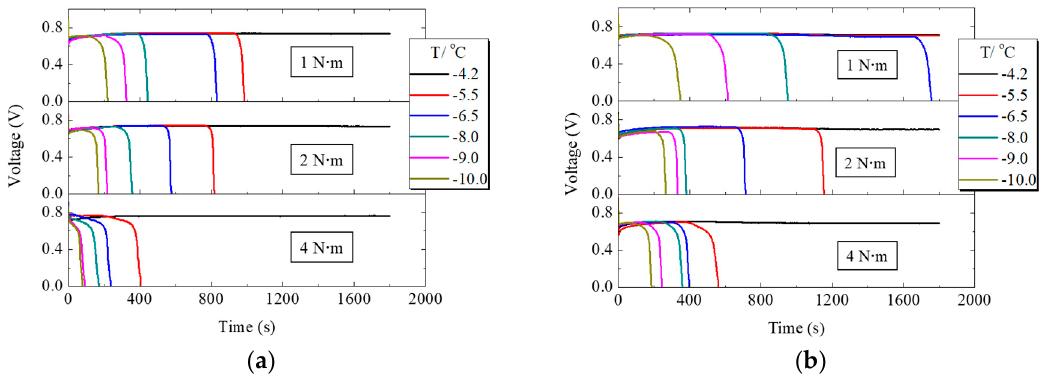
Figure 6. Voltage variation of PEMFC with conventional microporous layer (C-MPL) & GDL and H-MPL & conventional gas diffusion layer (C-GDL) under different assembly pressures: ( a ) Voltage changes of PEMFC with C-MPL & GDL; ( b ) Voltage changes of PEMFC with H-MPL & C-GDL.